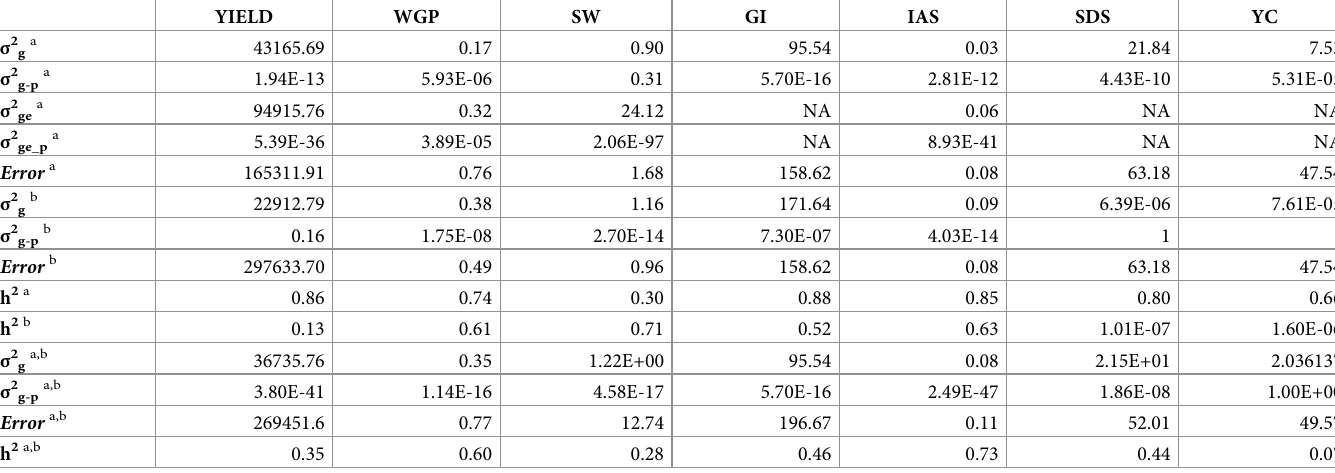
YIELD: yield (Kg/ha); WGP: whole grain protein; SW: specific weight; gluten index, GI; initial agronomic score, IAS; sedimentation index, SDS; and yellow color, YC); g : genotype variance; g-p : significance test for genotype variance; ge : genotype-by-environment interaction variance; ge-p : significance test for genotype-by-environment interaction variance. NA: ’ge’ couldn’t be calculated due to data without any replications. a Durum wheat varieties. b Experimental durum wheat